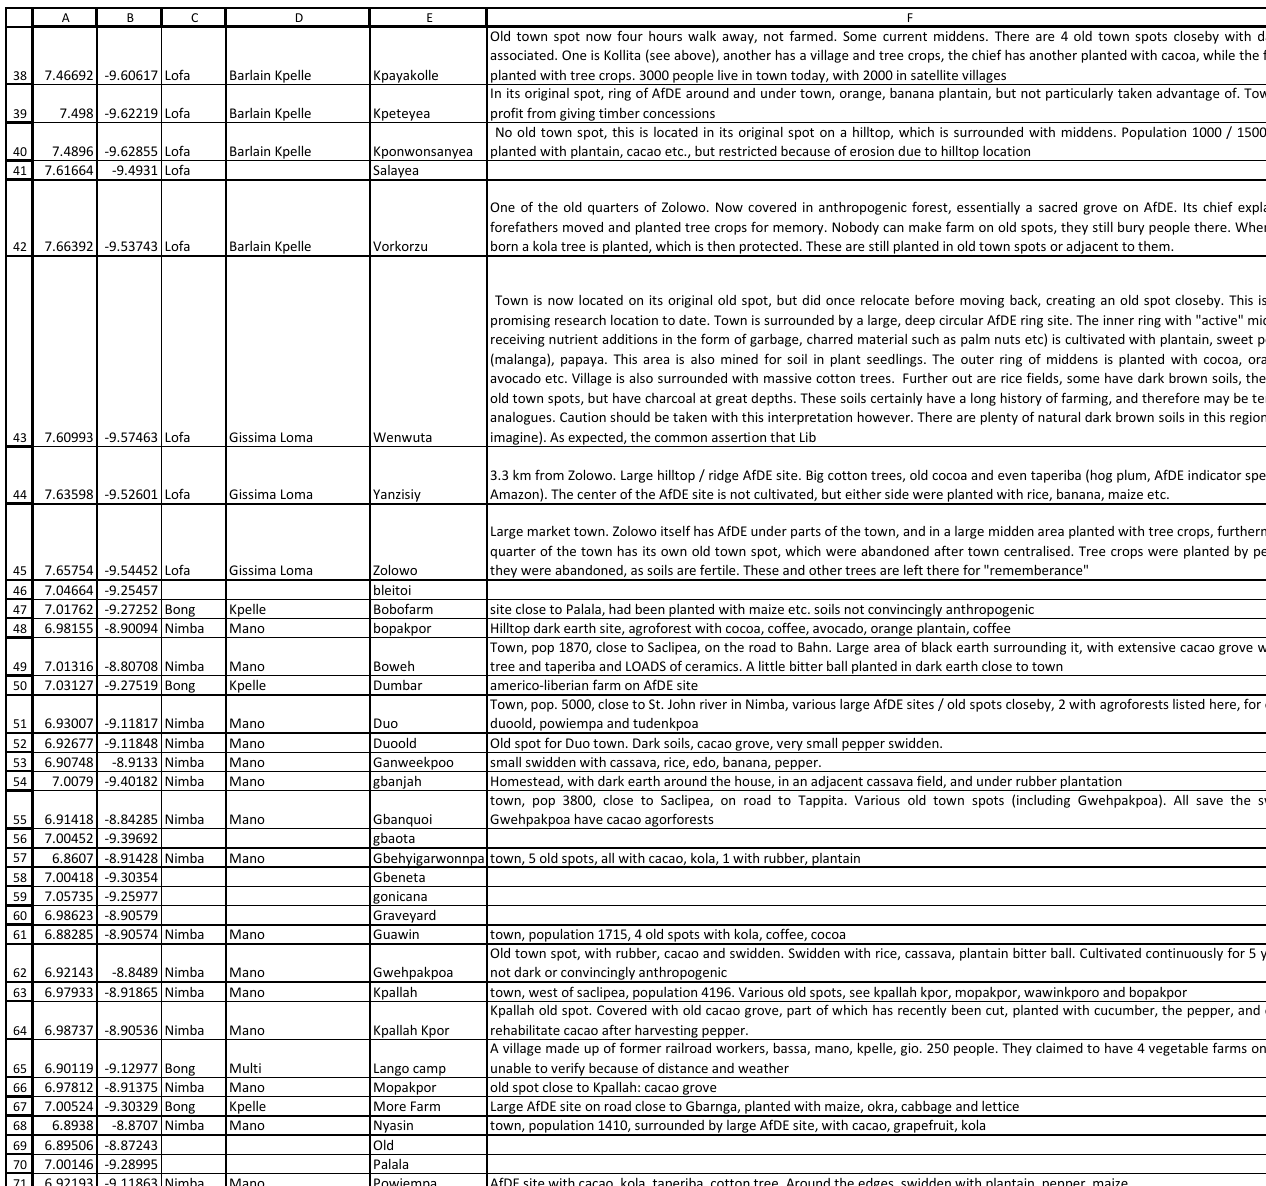
AfDE site with cacao, kola, taperiba, cotton tree. Around the edges, swidden with plantain, pepper,